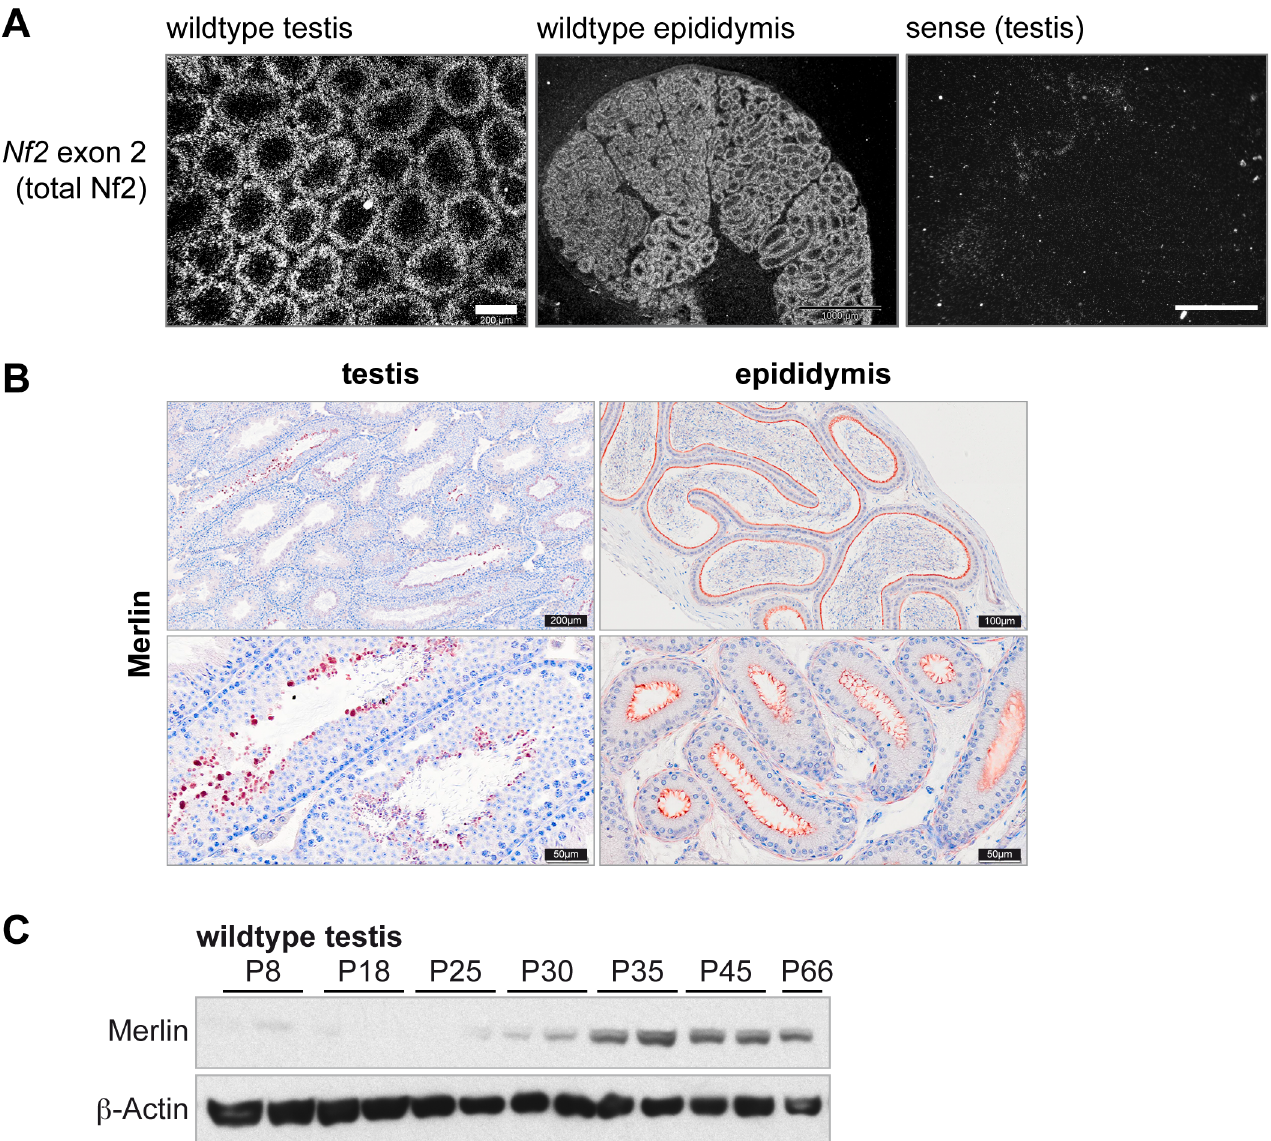
Fig 3. Nf2 is expressed in the seminiferous and epididymal epithelium. (A) In situ hybridisation analysis using radioactively labelled probes targeting exons 1 – 4 of Nf2 . Nf2 specific signals were present in the seminiferous tubules but not the interstitium of the testis (scale bar = 200 μ m) and in all tubules of the epididymis (scale bar = 1000 μ m). (B) IHC staining shows Merlin to be abundantly expressed in residual bodies in the testis and at the apical site of the epididymal epithelium. (C) Western blot analysis of Merlin protein levels in testicular lysates at different post-natal stages showing elevated expression of Merlin from P30